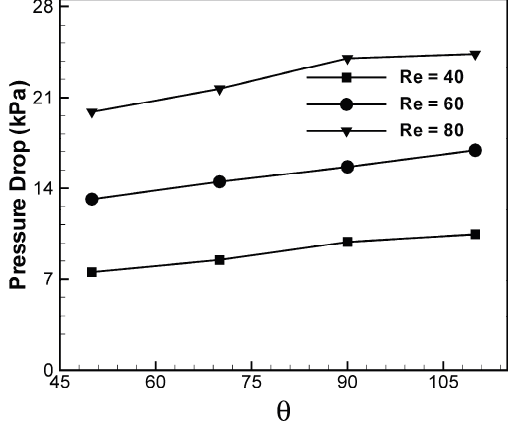
Figure 11. Effect of rhombic angle on the pressure drop in the three-split micromixer for various Reynolds